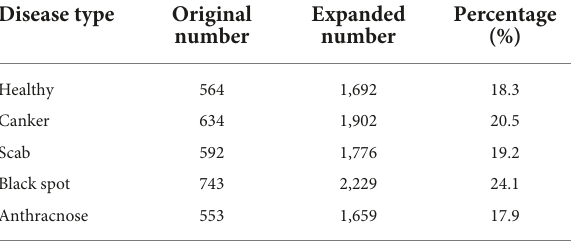
TABLE 2 Number and proportion of citrus